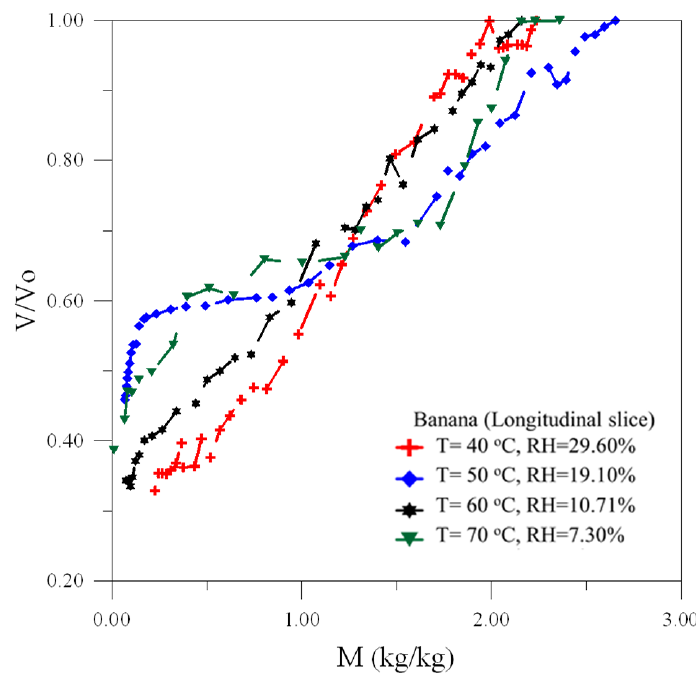
Figure 4. Dimensionless volume of the longitudinal cut banana as a function of moisture content.